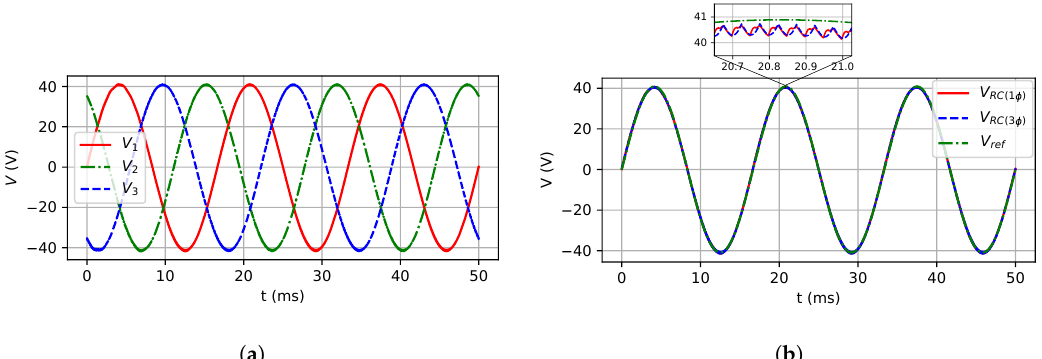
Figure 13. Load phase voltages for R load case: ( a ) Three-phase model; ( b ) Single-phase and three-phase (leg 1)